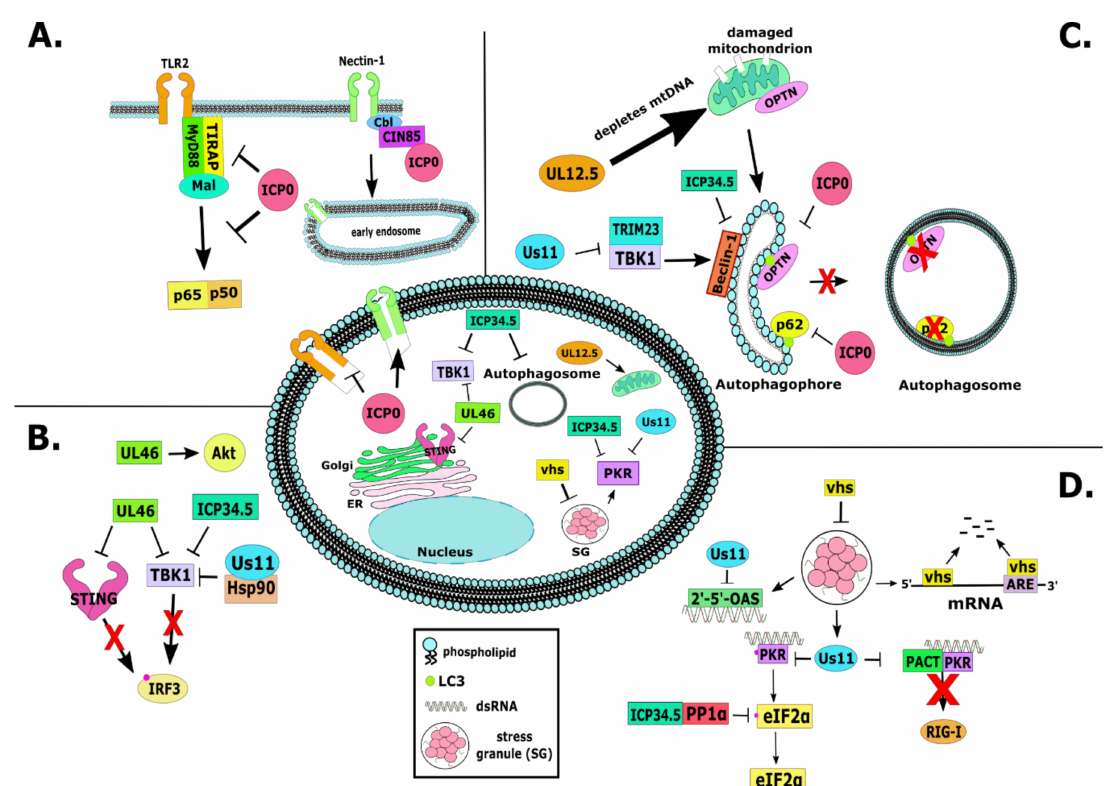
Figure 2. Cytoplasmic functions of some non-essential HSV-1 proteins. ( A ): ICP0 participates in two major functions in the cytoplasm. First, ICP0 degrades the TLR2 adaptors TIRAP and Mal, thus blocking NF- κ B activity. ICP0 also binds to the endocytosis adaptor CIN85 and along with Cbl promotes internalization of the viral entry receptor Nectin-1. This is a mechanism to promote progeny virus spread to uninfected cells. ( B ): The tegument protein U L 46 blocks STING and TBK1, which prevents stimulation of interferon-regulated genes. ICP34.5 and U S 11 are also involved in blocking TBK1, emphasizing the importance of blocking TBK1 activity during HSV-1 infection. ( C ): The autophagy pathway is blocked during HSV-1 infection through binding of ICP34.5 to Beclin-1, thus preventing maturation of the autophagophore to an autophagosome. ICP0 has also been found to cause downregulation of p62 and OPTN proteins during infection, which may also serve as another mechanism of blocking selective autophagy. It has also been found that the protein encoded by U L 12.5 causes depletion of mtDNA during infection, which causes damage to mitochondria. ( D ): HSV-1 prevents host translational shutoff from occurring during infection. One mechanism is through ICP34.5 binding to both PP1a and eIF2 α , causing dephosphorylation of eIF2 α and preventing shutoff of translation. HSV-1 also encodes vhs, which is a viral RNase that degrades AU-rich element (ARE) containing mRNAs. It has also been shown that vhs prevents the formation of cytoplasmic stress granules (SGs) during infection, which contain dsRNA that would otherwise cause PKR activation. HSV-1 also encodes U S 11, which blocks PKR, thus blocking host translational shutoff and innate immunity activation, as well as blocking PKR and PACT-induced activation of RIG-I during